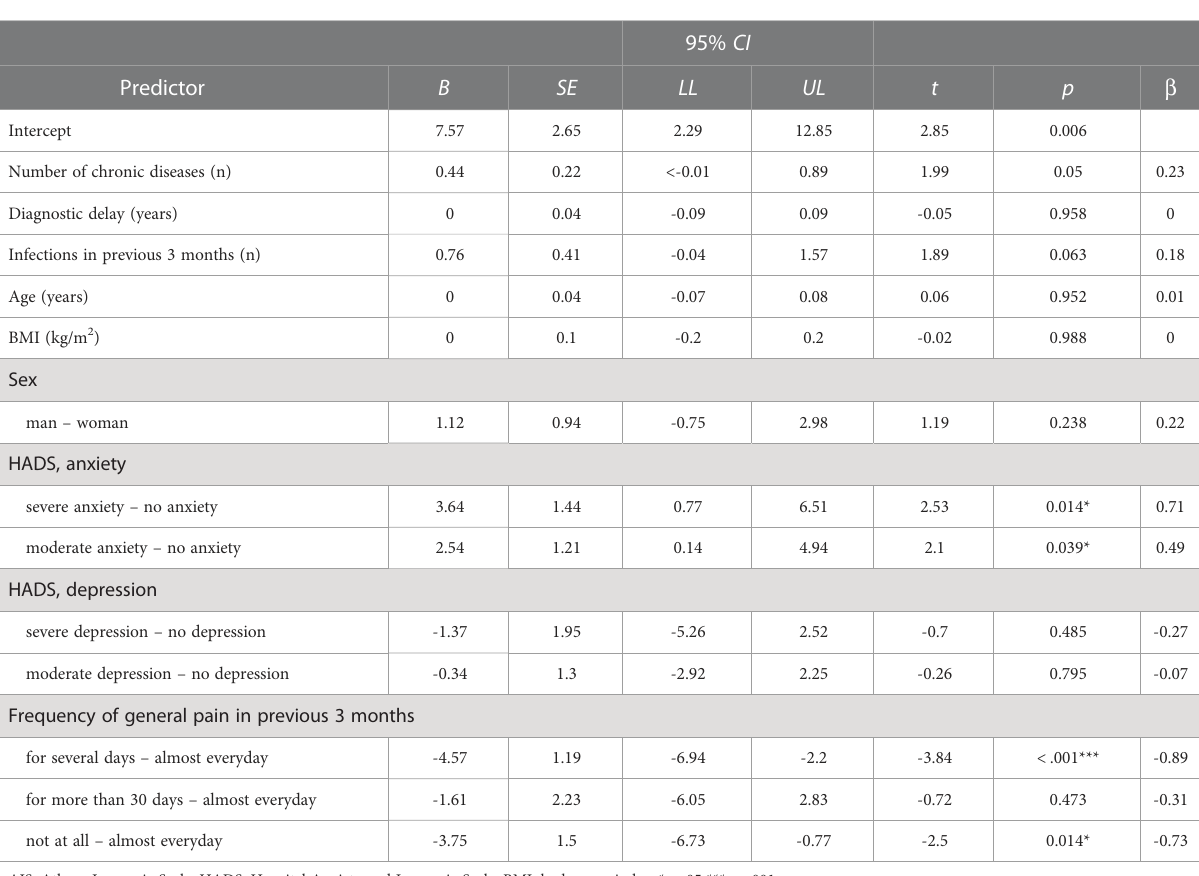
TABLE 8 Multiple linear regression model for AIS.